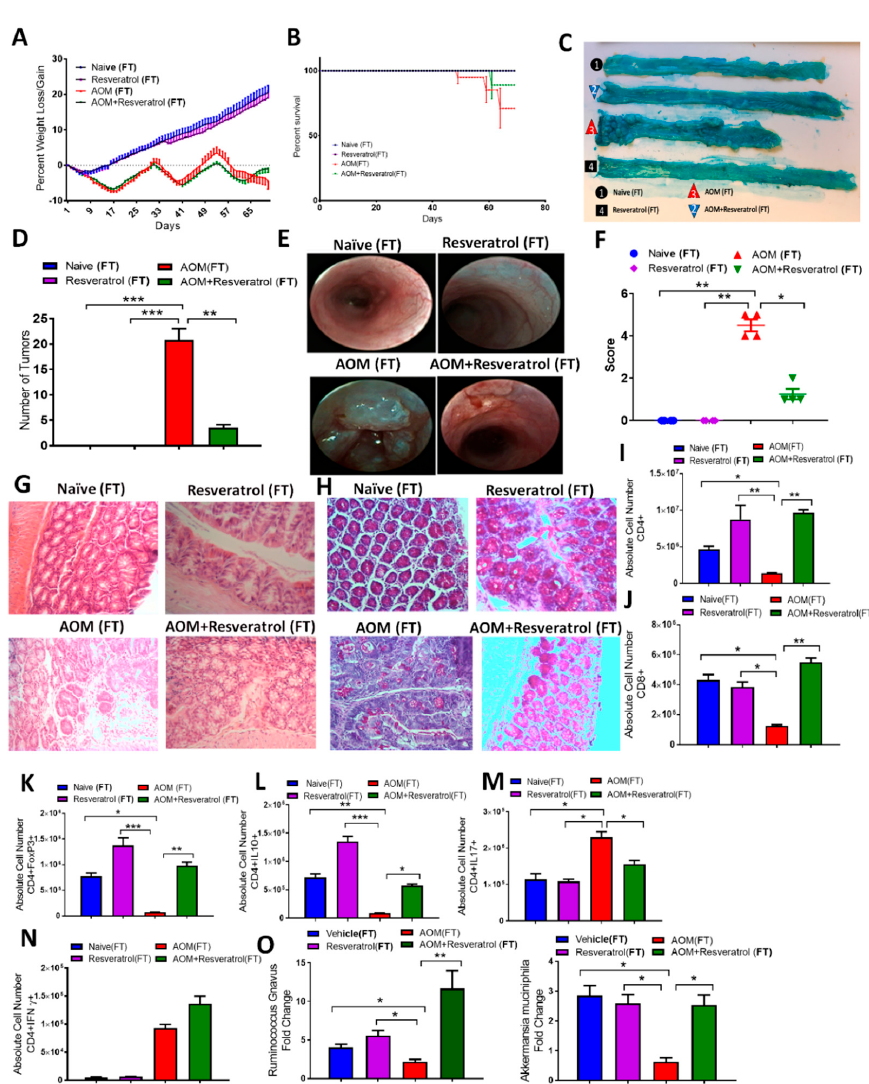
Figure 3. Results from fecal transfer (FT) experiments in AOM-induced CRC model. Antibiotic-treated C57BL/6 mice were injected i.p. with 10 mg of AOM to induce colorectal cancer followed by 3 cycles of 2% DSS. Fecal material was inoculated into recipient mice from the following donors: Naïve ( n = 4), Resveratrol ( n = 4), AOM ( n = 4), and AOM + Resveratrol ( n = 4). Clinical parameters consisted of percent weight loss ( A ) and survival ( B ), both of which were found to have significant di ff erences in AOM (FT) vs. AOM + Resveratrol (FT) groups. ( C ) Representative colons stained with 1% Alcian blue. ( D ) Bar graph depicting number of tumors counted in each experimental group. ( E ) Representative colonoscope images from experimental groups. ( F ) Bar graph depicting scores after examination of tumor polyps detected during colonoscopies. ( G ) Representative colon sections stained with H&E; scale bar = 100 µ M at 40x objective. ( H ) Representative colon sections that underwent PAS staining; scale bar = 100 µ M at 40x objective. ( I , J ) Bar graphs depicting absolute cell numbers in MLN for general T cells T helper ( I ) and cytotoxic ( J ) T cells. ( K – N ) Bar graphs depicting absolute cell numbers in MLN for Tregs ( K ), Th cells producing IL-10 ( L ), Th17 ( M ), and Th1 ( N ) cells. ( O ) PCR validation for the bacterial species Ruminococcus gnavus and Akkermansia muciniphila . Significance ( p -value: * p < 0.05, ** p < 0.01, *** p < 0.005) was determined by using one-way ANOVA and post-hoc Tukey’s test for bar / dot graphs, Mann–Whitney test for weight data, and log rank test for survival curve. Data are representative of at least 3 independent